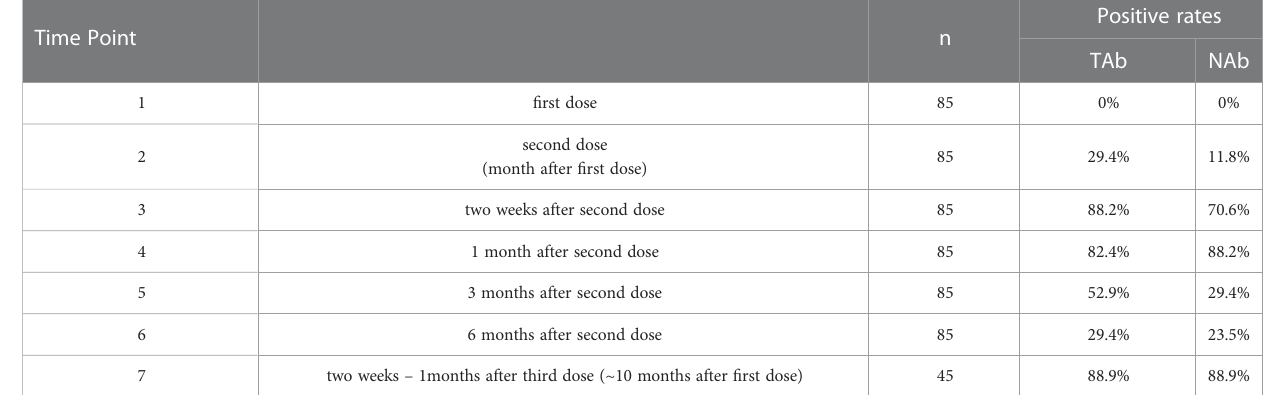
TABLE 2 Positivity rates of Pylon TAb assays and Pylon NAb assays during 10 months ’ follow-up of the participants.